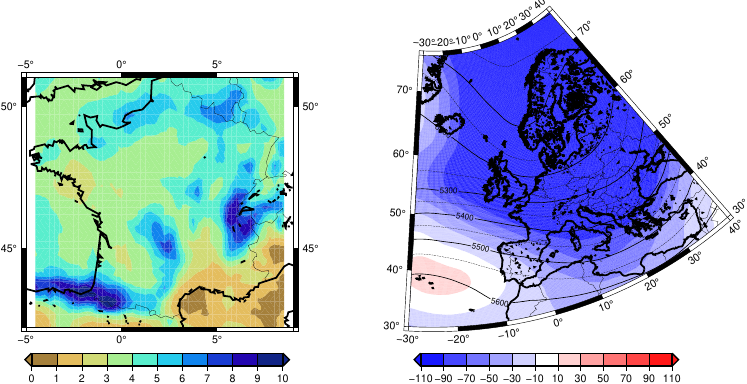
Figure 5. Left panel : mean precipitation rate (in mm/day) over France between 9 May 2008 and 1 April 2008. Right panel : mean anomalies of Z500 (in m) over the East North Atlantic region (colours). Contour lines indicate the mean Z500 (in